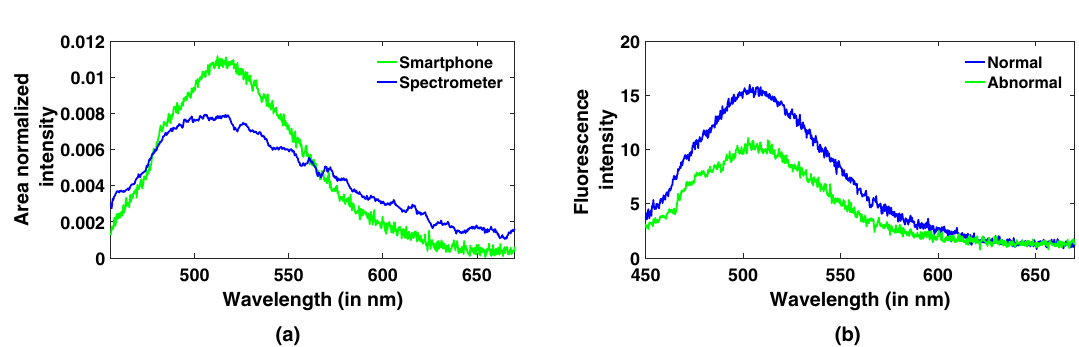
Figure 7. Typical plots of ( a ) polarized fluorescence spectra from smartphone and spectrometer, ( b ) normal and abnormal tissue spectra collected from smartphone based spectrometer.